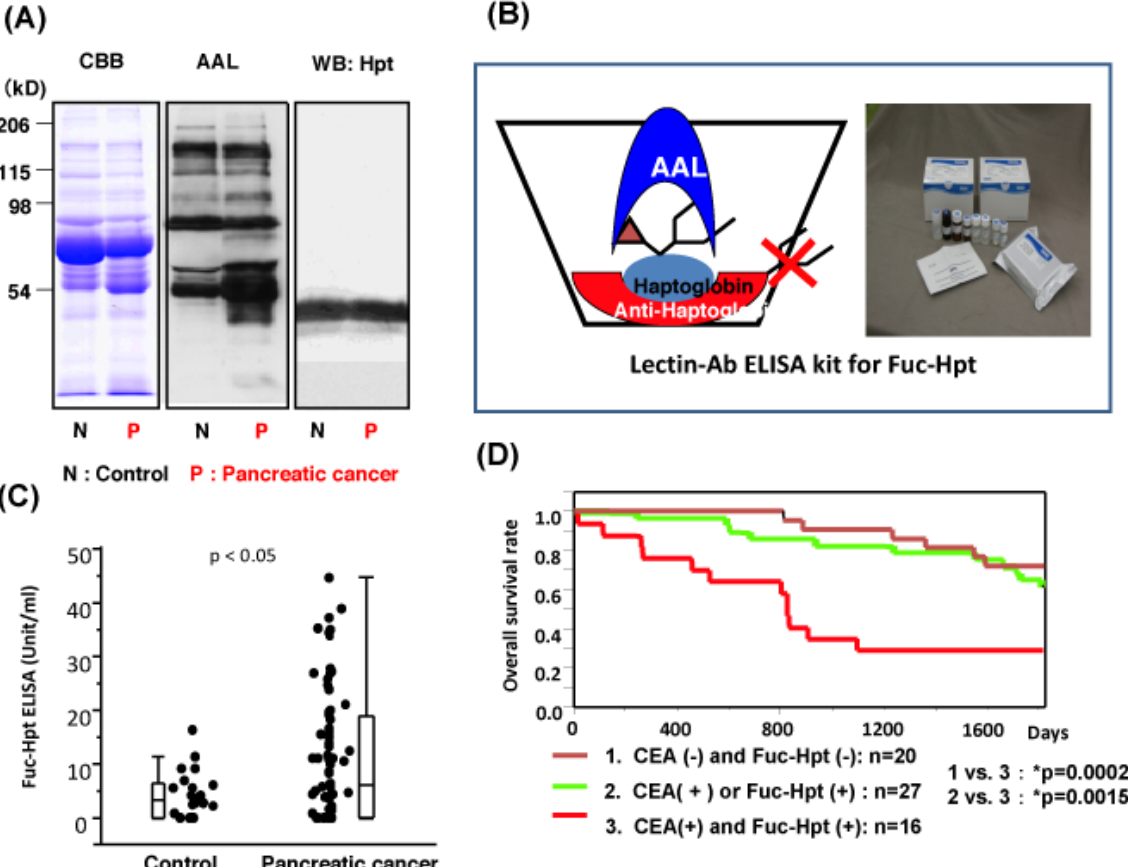
Figure 1. Fucosylated haptoglobin is a novel cancer biomarker for differential diagnosis and predicted prognosis. ( A ) Lectin blot using aleuria aurantia lectin (AAL) detected a protein of approximately 40 kDa from sera of patients with pancreatic cancer. Coomassie Brilliant Blue staining showed no changes in levels of this protein. This figure is cited from reference [22] with slight modification; ( B ) Establishment of lectin-antibody ELISA kit to measure Fuc-Hpt. Schematic system is shown; ( C ) Representative data of the Fuc-Hpt ELISA kit. Seventy-two cases of patients with pancreatic cancer and 22 healthy volunteers were assayed with 25 times dilution of sera. This data is cited from reference [28] with slight modification; ( D ) Combination assay of Fuc-Hpt and carcinoembryonic antigen is a marker for poor prognosis in patients with colorectal cancer after operation. This data is cited from reference [23] with slight